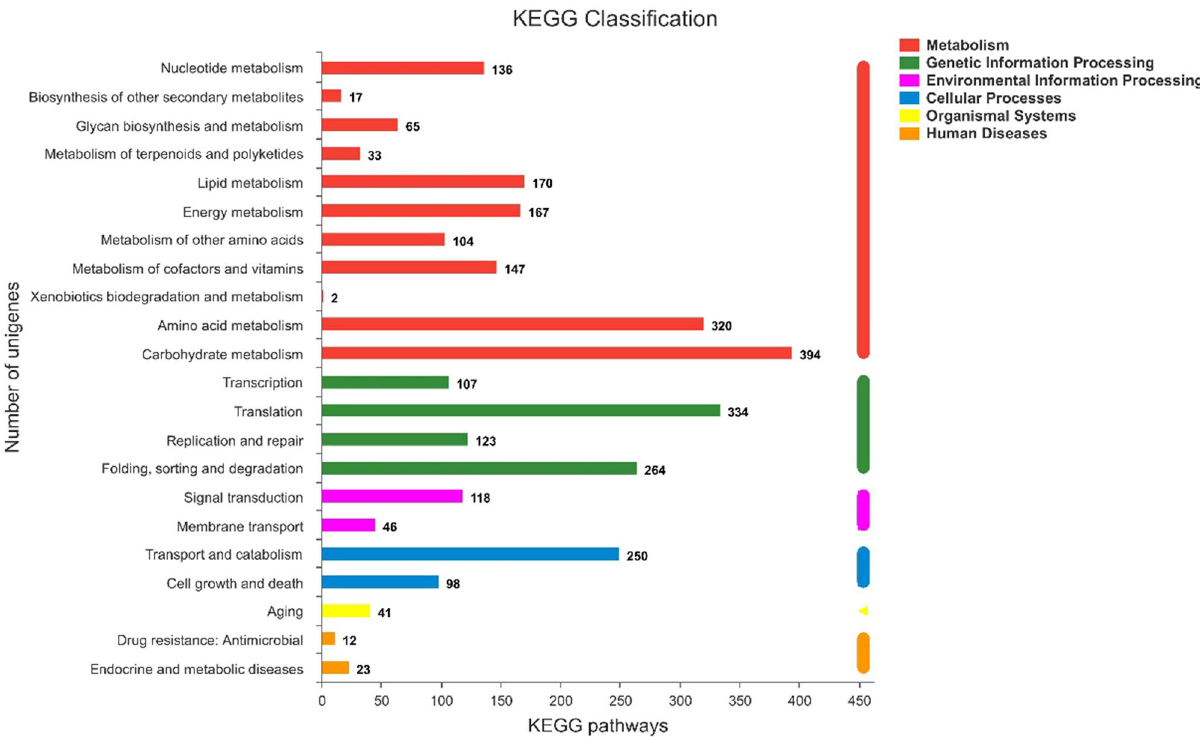
Figure 5. KEGG metabolic pathway of C. comatus . The Y-axis indicates the names of the KEGG metabolic pathways, and the X-axis indicates the number of genes.